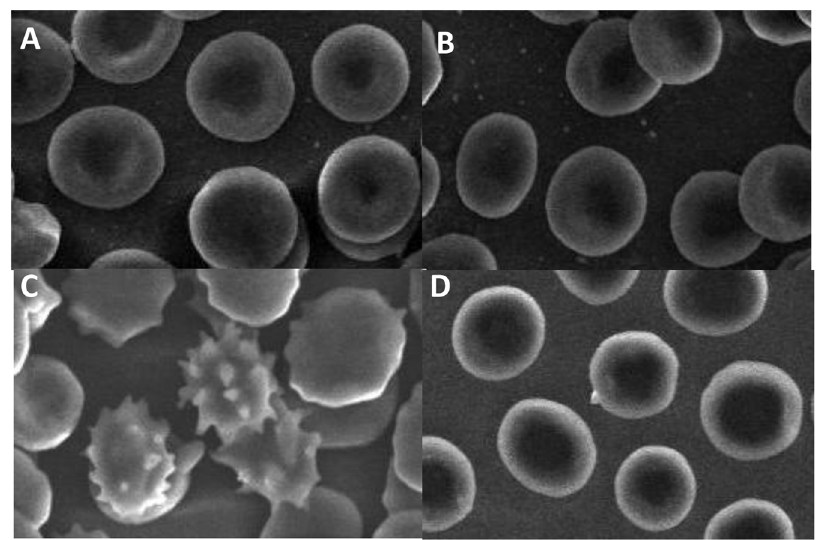
and Methods section. Magnification is 1000 fold.